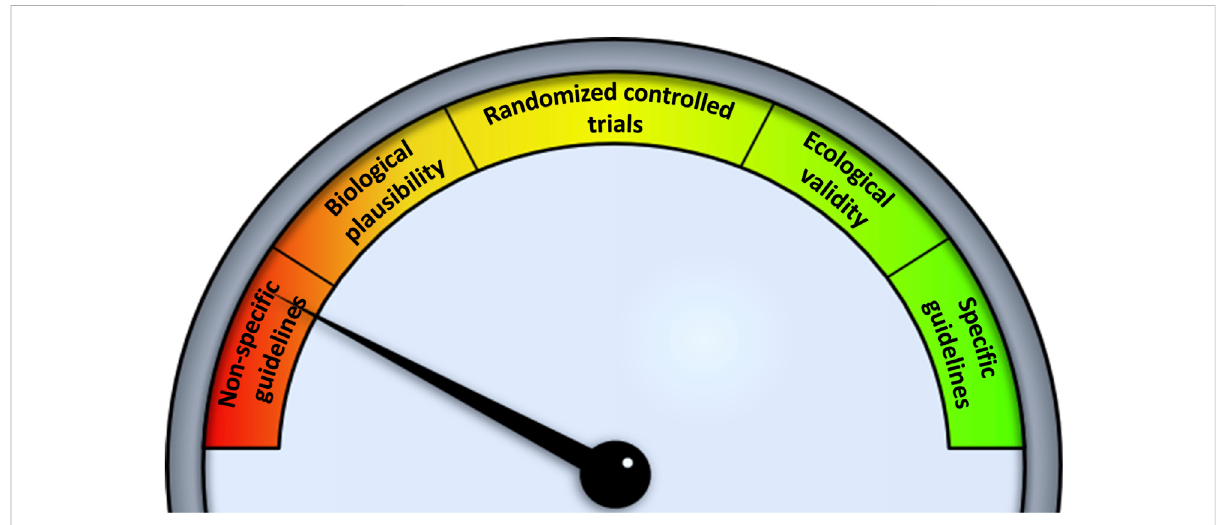
FIGURE 2 “ Moving the needle ” on current sedentary behavior research towards policy